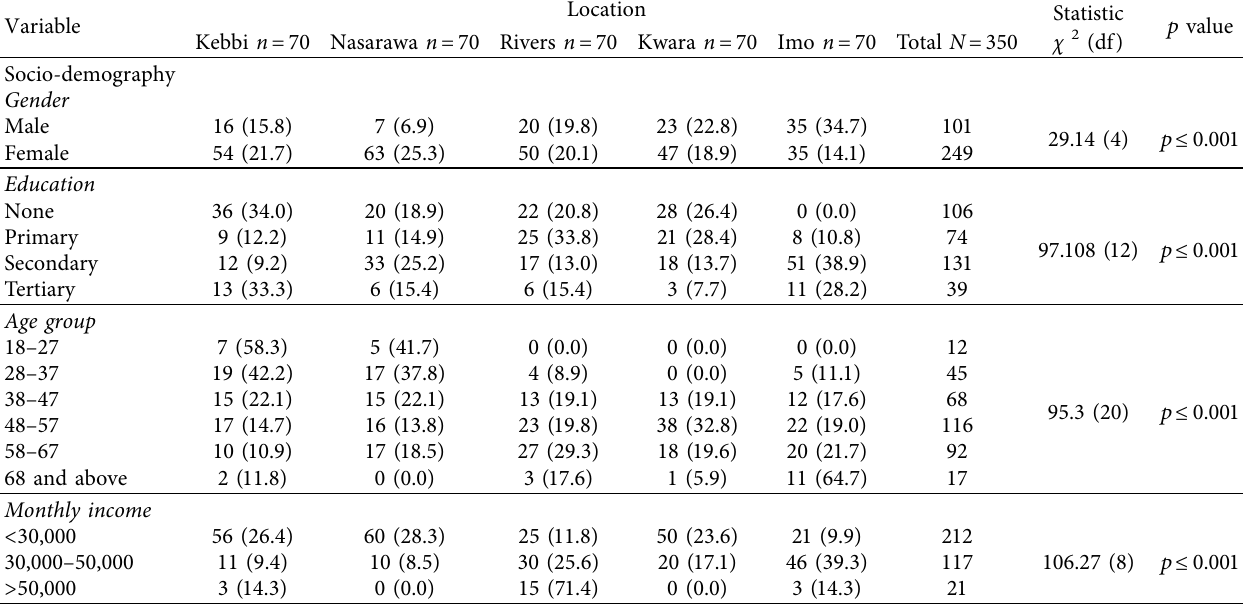
Table 1: Socio-demographic characteristics of